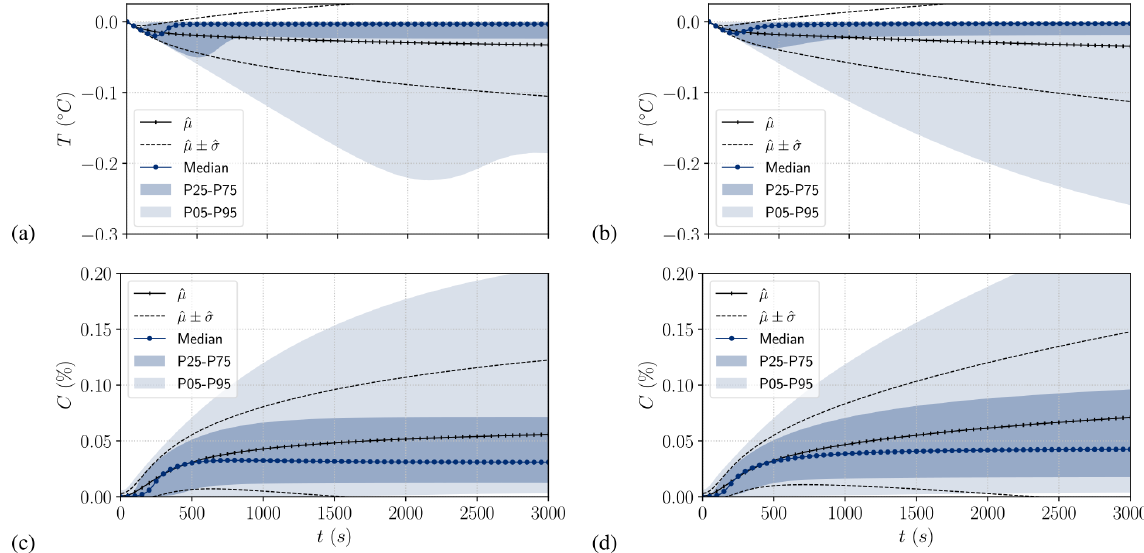
Figure 8. Uncertainty propagation results for SSC (case 3) for temperature (a) and frazil (c) and MSC (case 4) for temperature (b) and frazil (d) : mean, standard deviation, median, and the 5th, 25th, 75th and 95th percentiles computed for t k (0 ≤ k ≤ n t ).